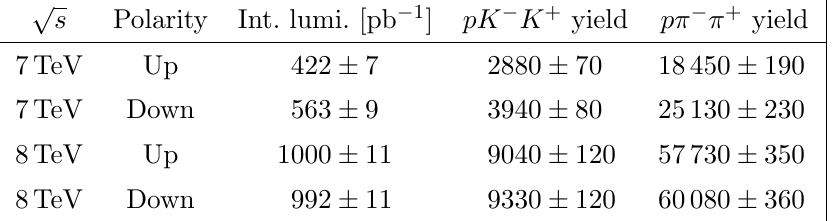
Table 1 . Signal yields measured in the (cid:12)t for each of the four subsets of the pK (cid:0) K + and p(cid:25) (cid:0) (cid:25) + data (two centre-of-mass energies, 7 and 8 TeV, and two polarities of the dipole magnet, up and down). The corresponding integrated luminosity of each subset is also